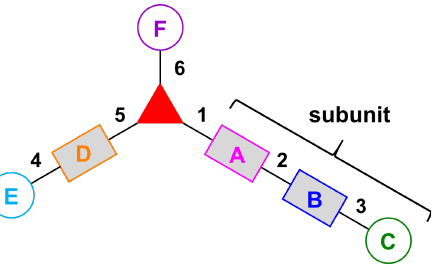
Figure 6. Representative graph [3][2] 3 [1] 3 (one three-arm hub, three two-arm hubs, and three appendages) with functional units ABCDEF and synthesis order 1–6.